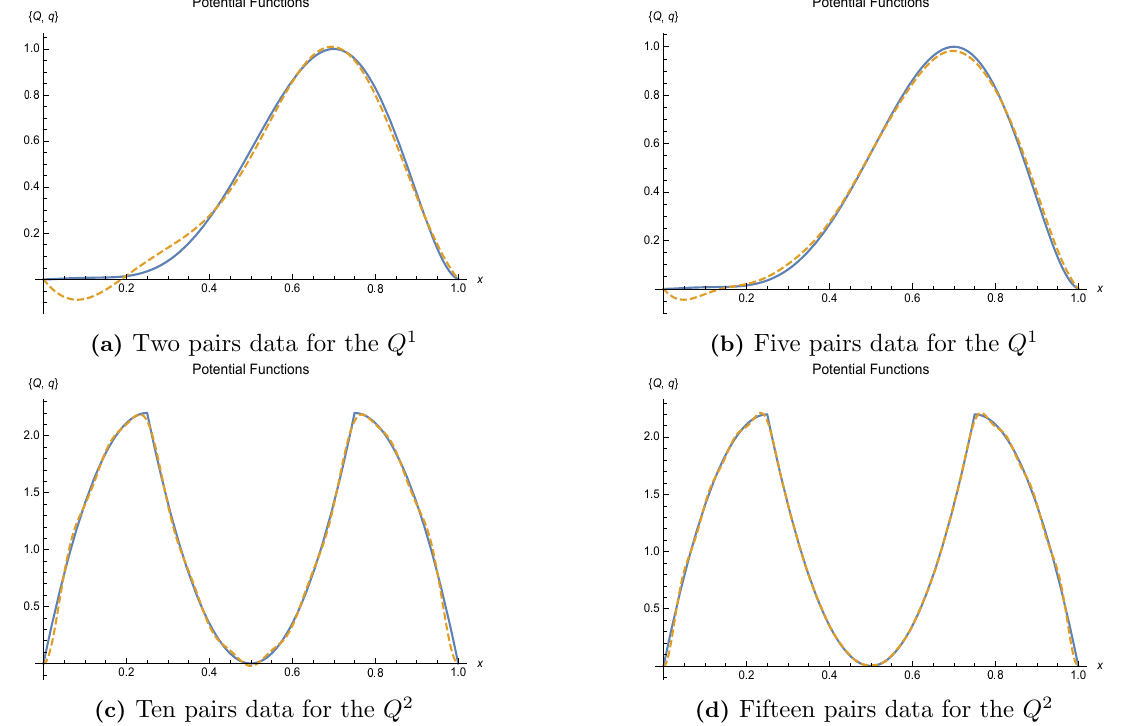
Figure 4. The graphics obtained for Q 1 ( x ) in (a), (b) and Q 2 ( x ) in (c),